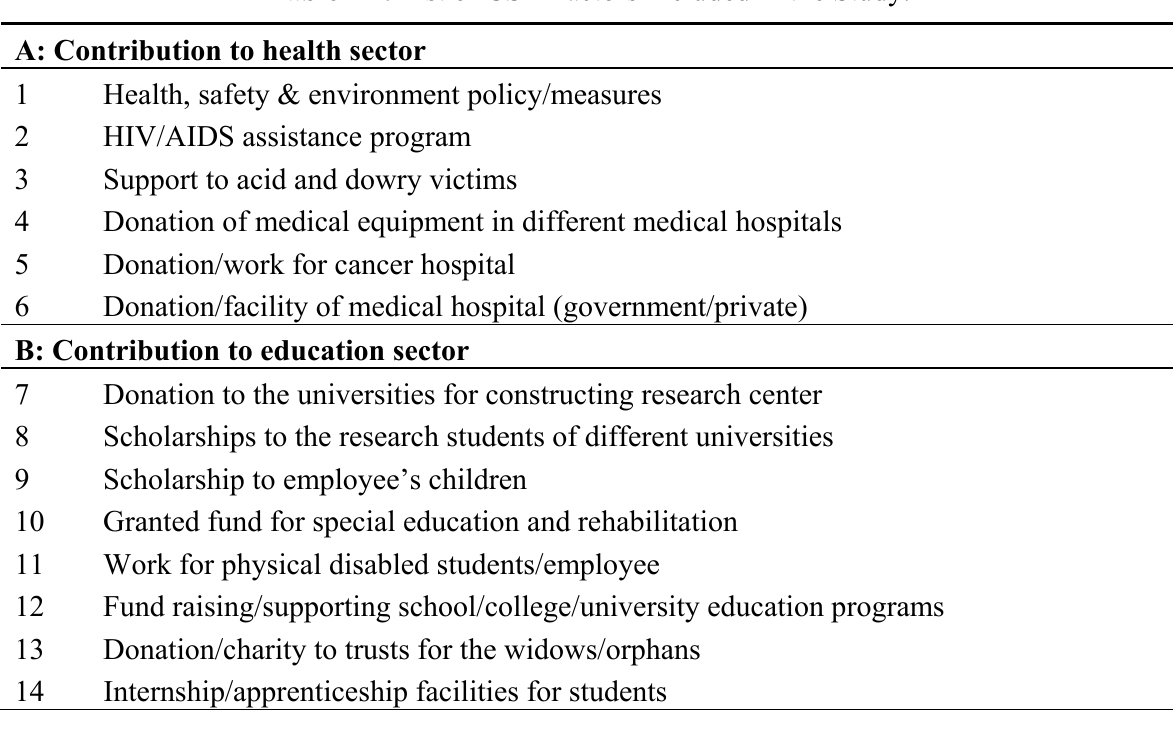
Table A1. List of CSR Factors Included in the